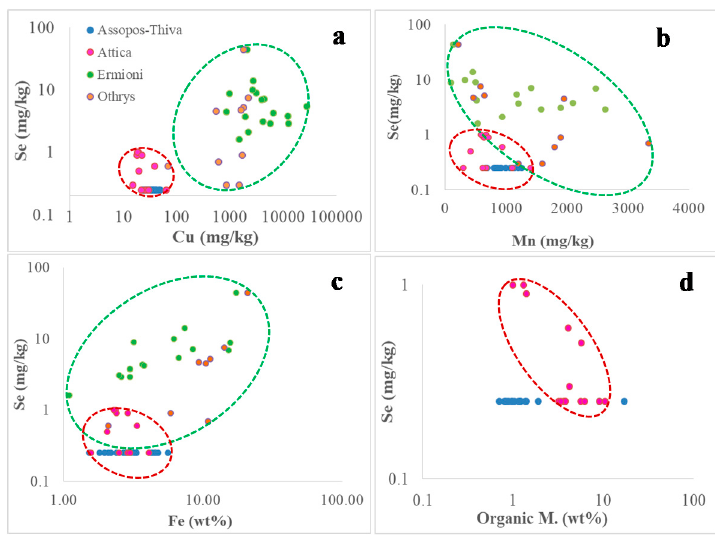
Figure 3. Plot of the Se vs. Cu, Mn, Fe and organic matter (M.) contents ( a – d ) in soils from the Assopos-Thiva and Attica basins, as well as the Ermioni and Othrys areas. Data from Table 1.